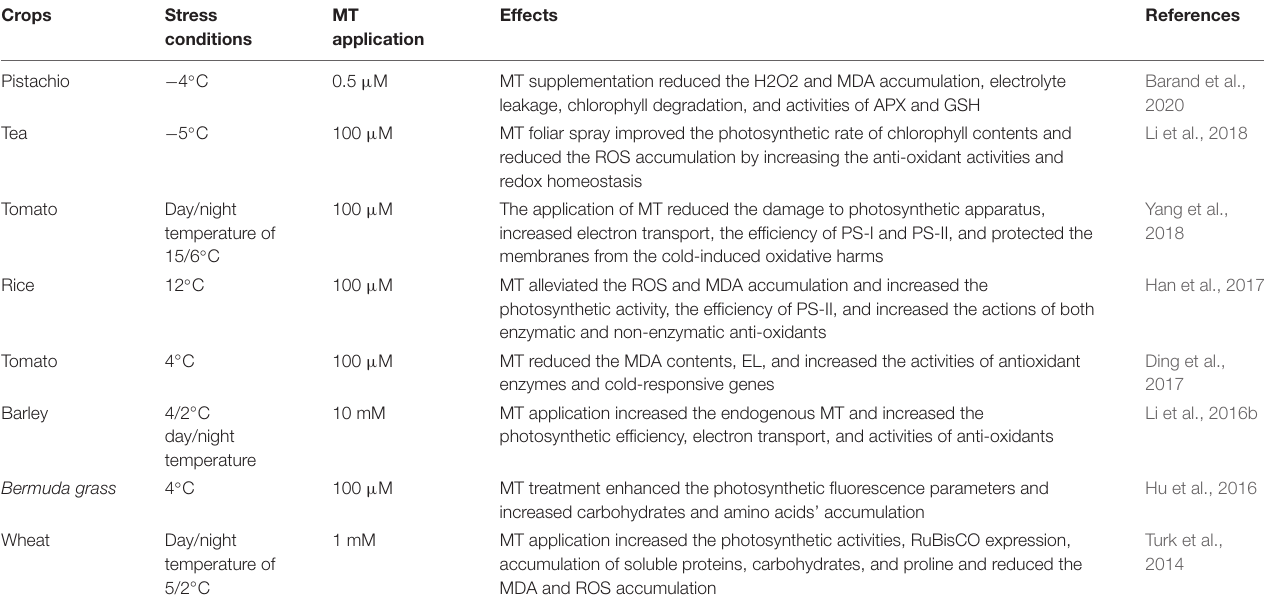
TABLE 3 | Role of melatonin in inducing cold stress tolerance in different plant species. Crops Stress